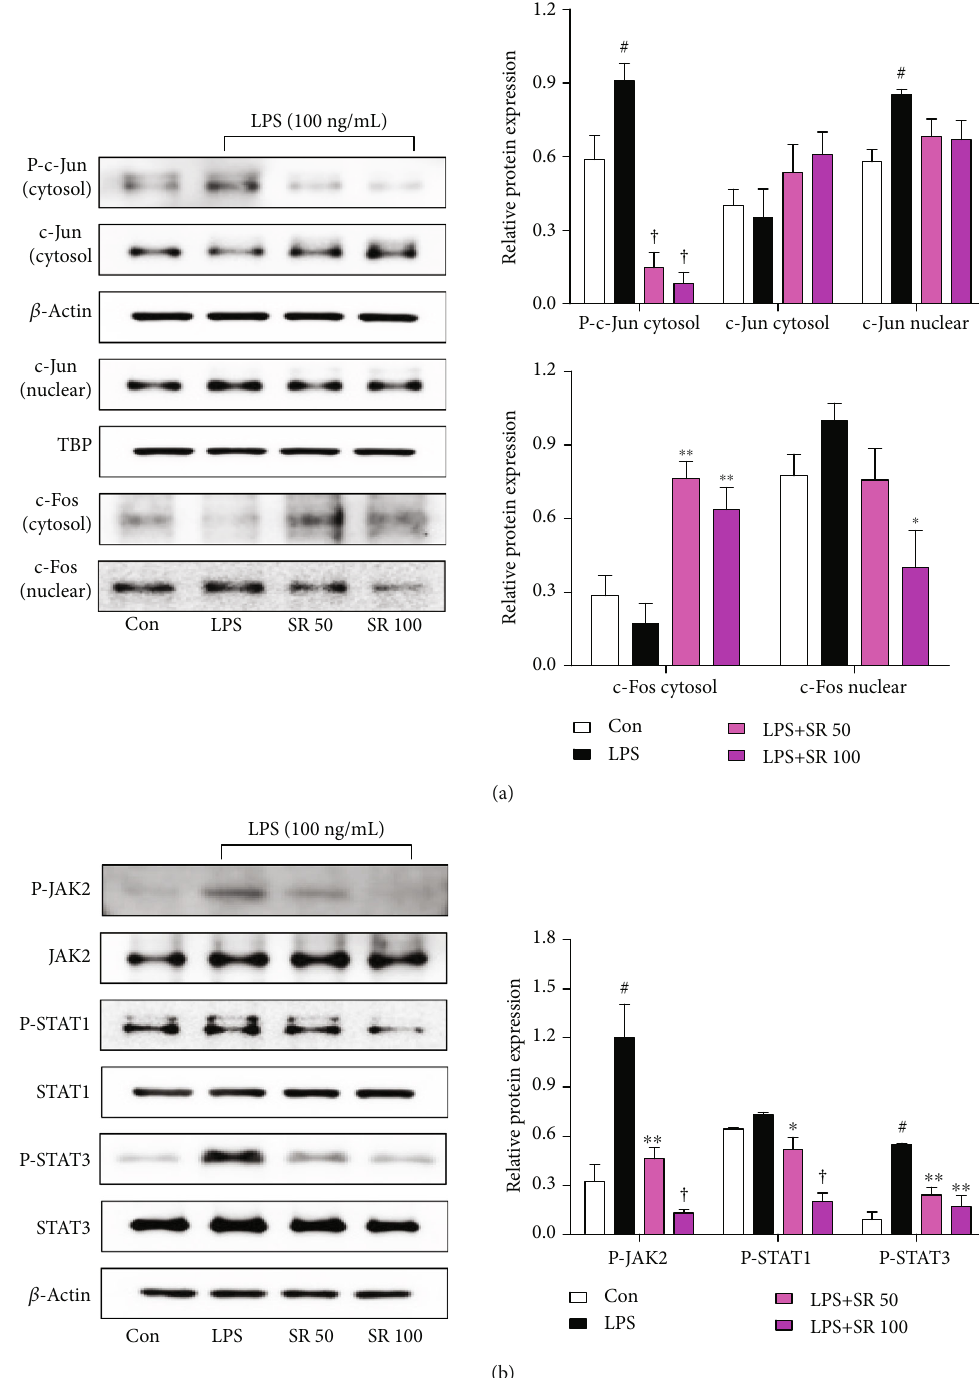
Figure 4: E ff ects of Saussureae Radix (SR) on the (a) nuclear translocation and phosphorylation of c-Jun and c-Fos and (b) phosphorylation of Janus kinase (JAK2), signal transducer and activator of transcription 1 (STAT1), and STAT3. Control cells were incubated with only fresh DMEM. Cells were stimulated with lipopolysaccharide (LPS) for (a) 1 or (b) 4 h. The histograms show protein levels relative to those of the internal control. # p < 0 : 05 (vs. control); ∗ p < 0 : 05 , ∗∗ p < 0 : 01 , and † p < 0 : 001 (vs.